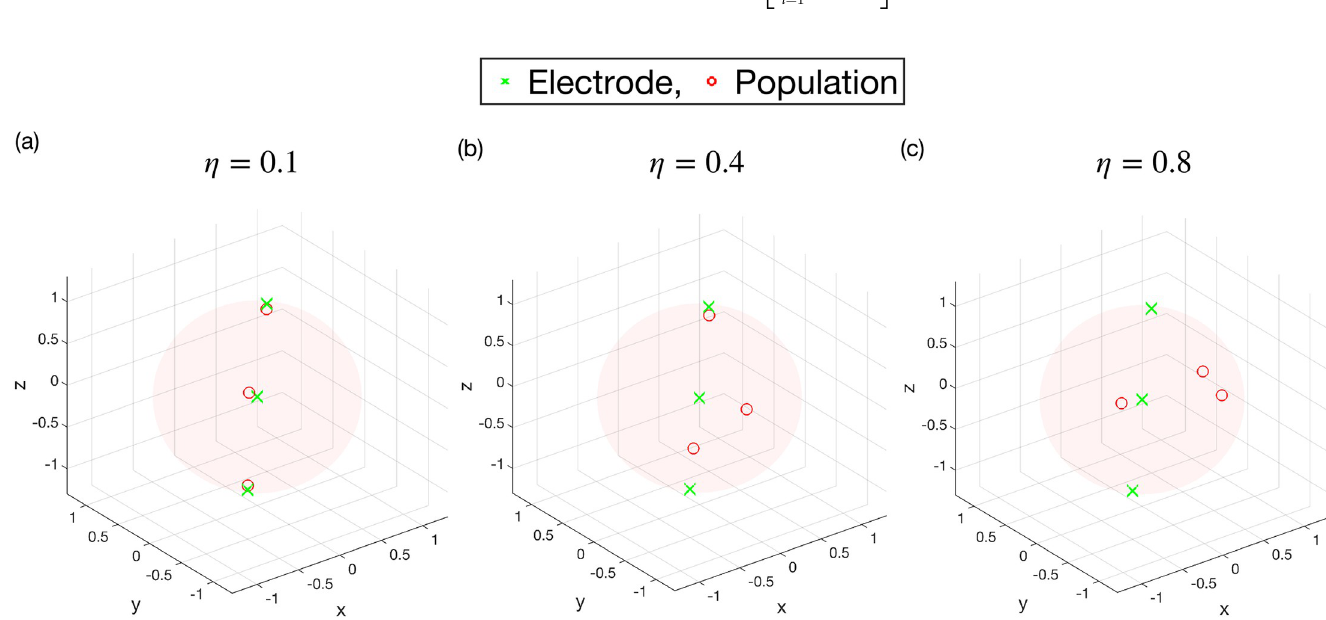
Fig 5. Visualisations of 3 electrode 3 population systems for different values of the configuration parameter η . The 3 electrodes lie on a straight line across a sphere of unit diameter. Panel (a) shows a configuration for η = 0.1, where each population is placed very close to an electrode. Panels (b) and (c) show systems for η = 0.4 and η = 0.8, respectively, where the populations are more dispersed relative to the electrodes. In this scenario, stimulation from electrodes may affect multiple populations.